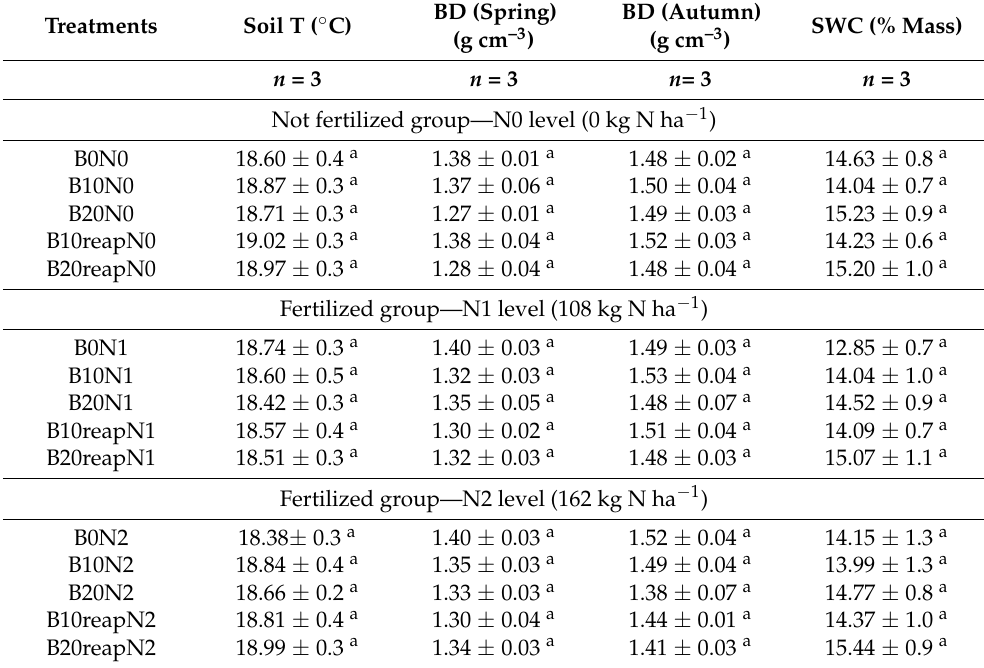
Table 4. Effect of biochar application on selected soil physical properties (soil temperature, bulk density, soil water content) measured during the growing season of 2019 (means ± standard errors). Different letters ( a ), within columns for each fertilized group, indicate that treatment means are significantly different at p < 0.05, according to the Tukey